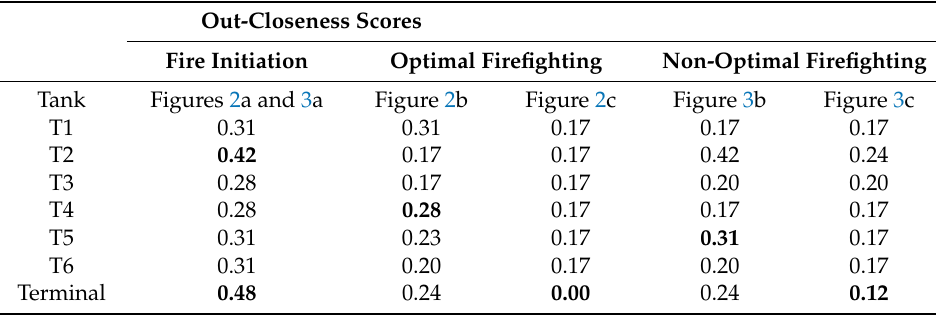
Table 1. Tanks’ and terminal’s out-closeness scores for the graphs in Figures 2 and 3.